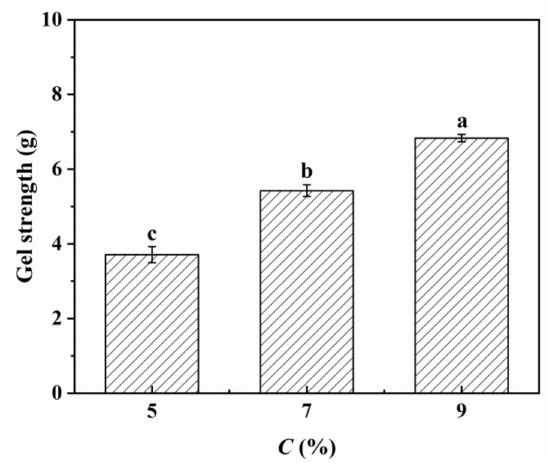
Figure 6. Gel strength values of the Pickering emulsion gels developed by sorghum flour at ϕ = 70% and c = 5, 7 and 9%.